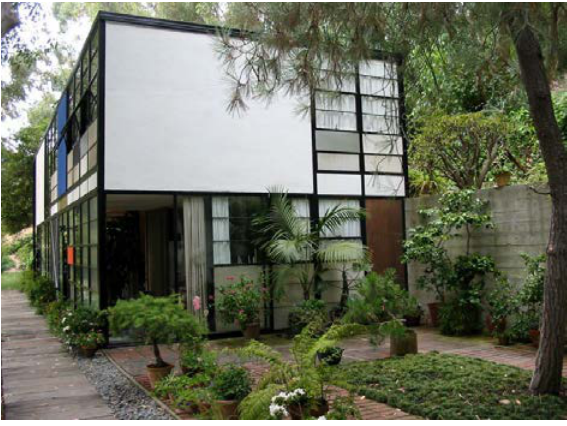
Figure 1: Eames House (case study house